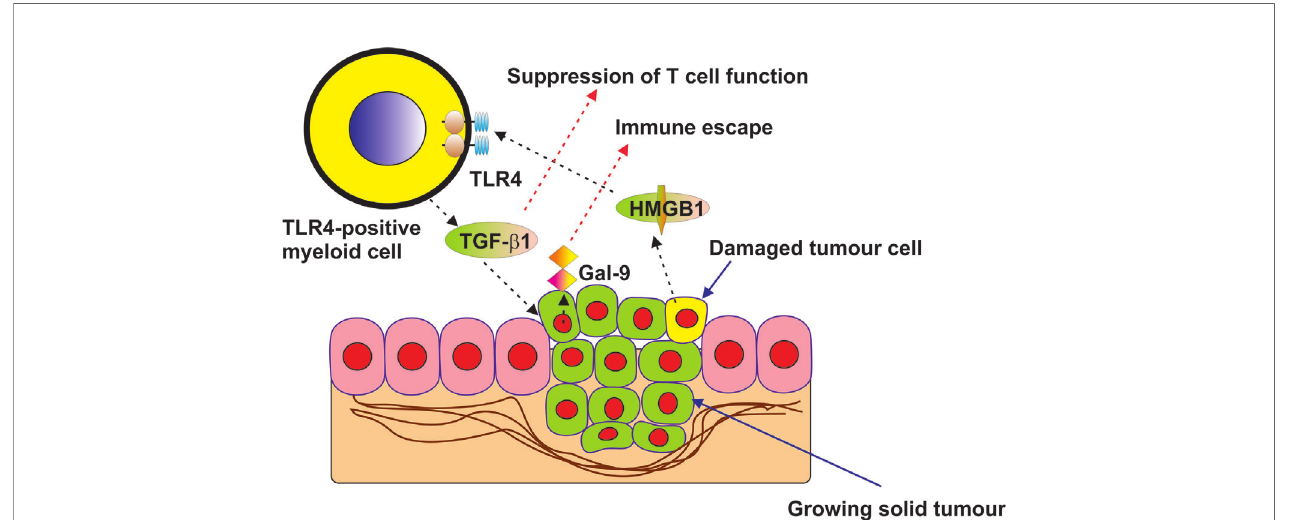
FIGURE 8 | Proposed mechanism of indirect upregulation of galectin-9 expression by HMGB1 in solid tumour cells lacking TLR4 expression is presented in the